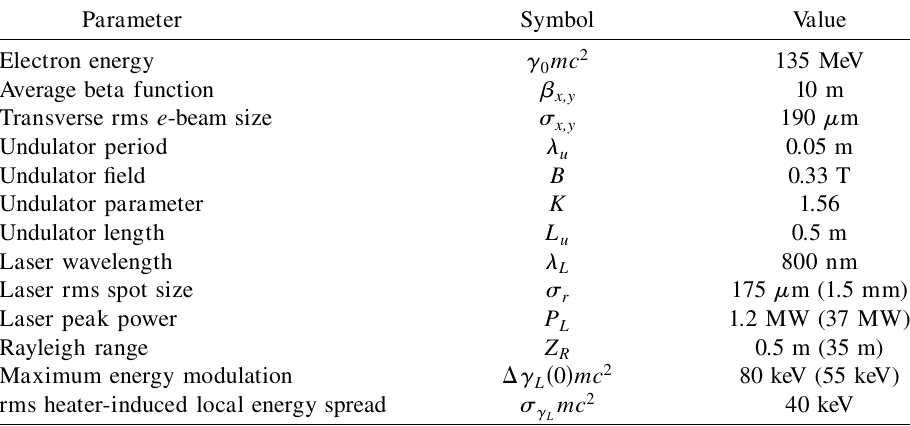
TABLE II. Main parameters for the LCLS laser heater.